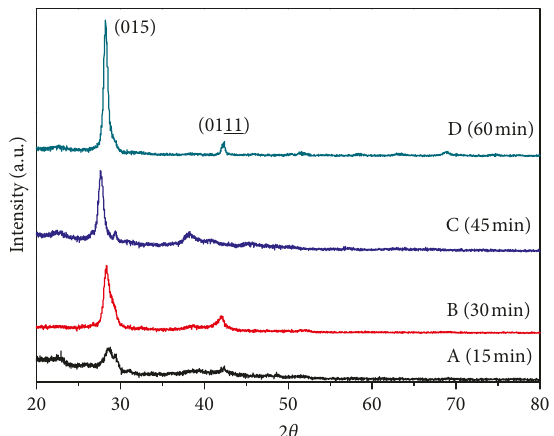
Figure 1: XRD spectra of Sb 2 Te 3 thin films fabricated under different deposition times: 15, 30, 45, and 60min. Table 1: XRD analysis of Sb 2 Te 3 thin films calculated from the (015)